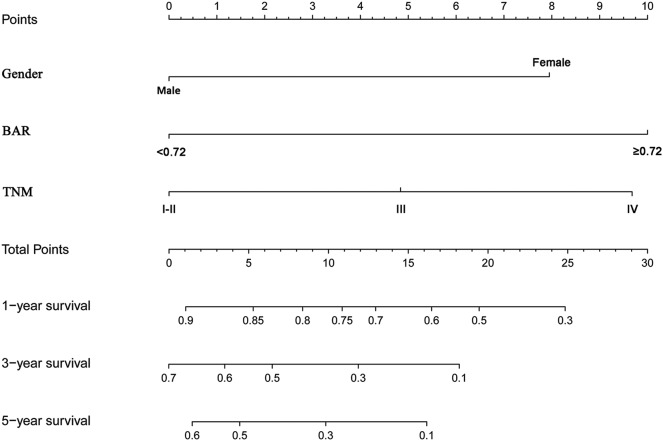
Nomogram model based on gender, BAR and TNM stage in the prediction of 1-, 3-, and 5- year OS in SCCE patients. The nomogram was used by summing the points identified on the points scale for each variable. The total points projected on the bottom scales indicate the probability of 1-, 3-, and 5-year survival. BAR, ApoB/ApoA-1.